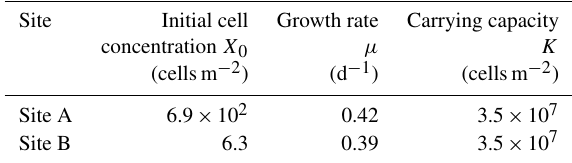
Table 1. List of the parameters of a logistic model of snow algal growth obtained from data from each study